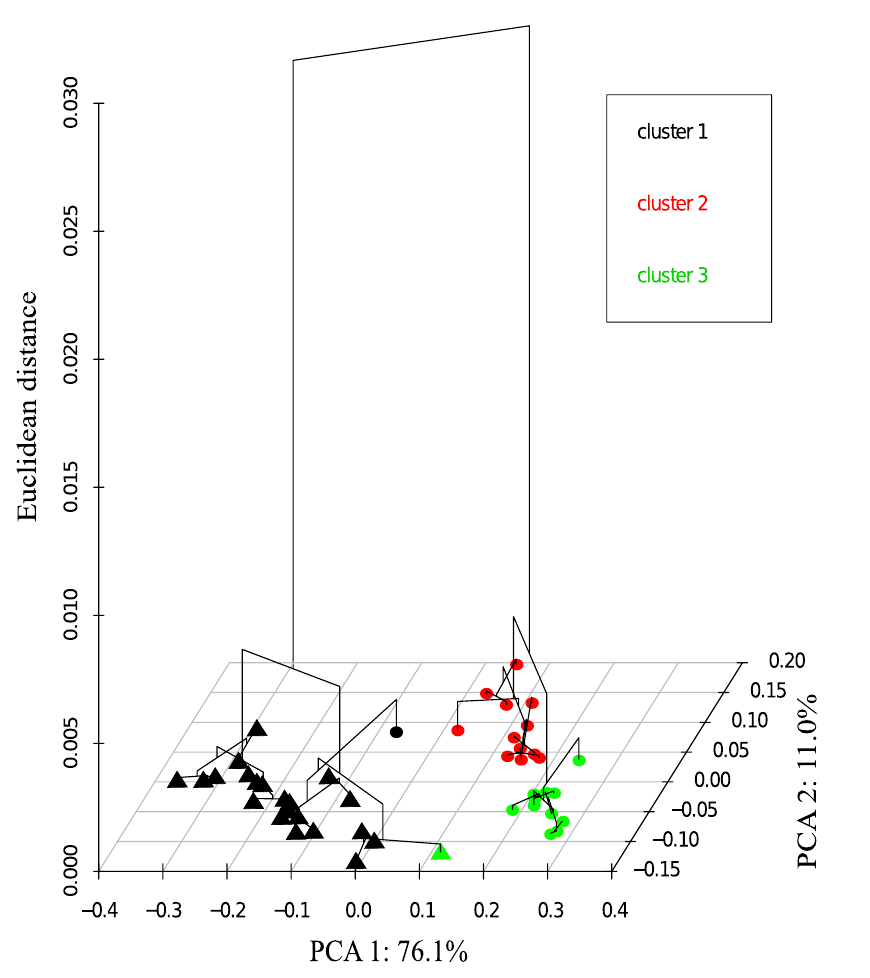
Figure 3. Hierarchical clusters of ice algae (triangles) and C. centralis (circles) fatty acid profiles overlaid on the first two principal component axes.